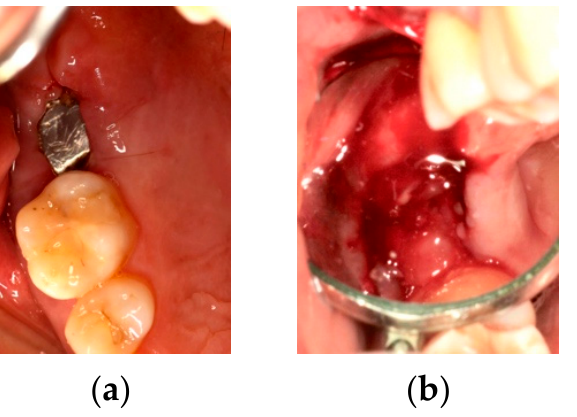
Figure 21. ( a ) Removal of sutures after 3 weeks; ( b ) extensive healing tissue is observed which has completely covered the previously exposed roots.